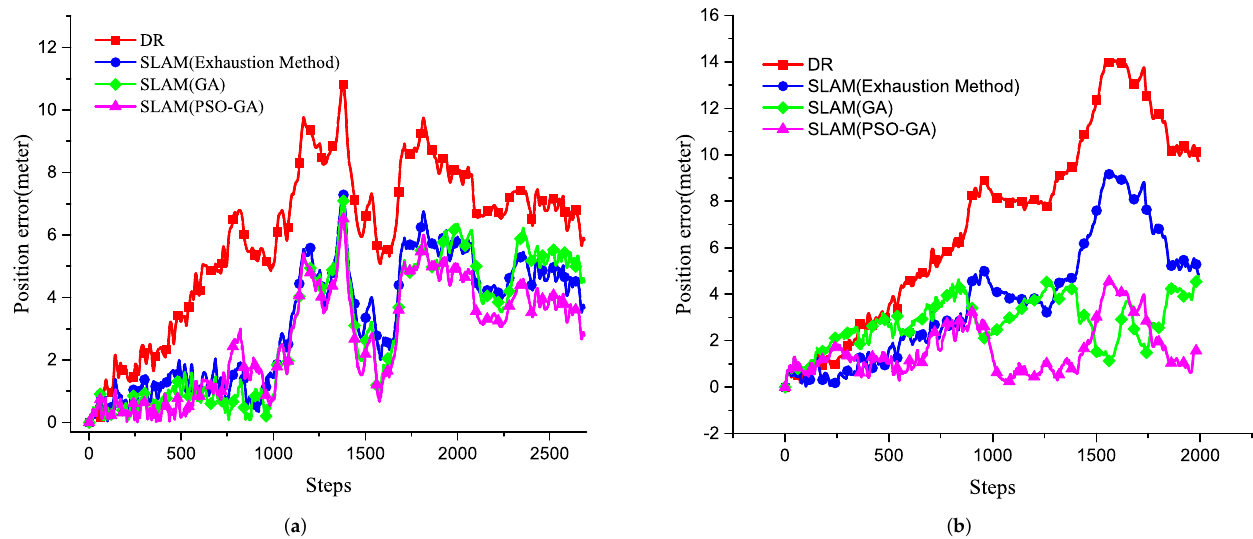
Figure 11. Localization error of different methods. ( a ) Localization error of different methods in Test 1. ( b ) Localization error of different methods in Test